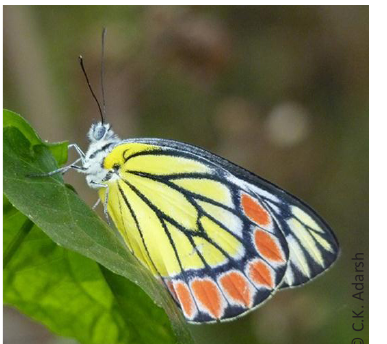
14. Eurema brigitta Small grass yellow